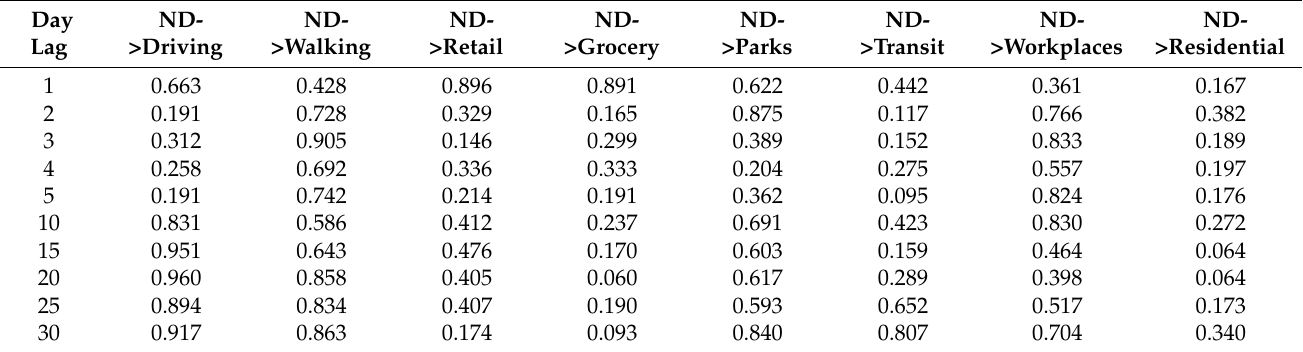
Table A18. New_deaths (ND), Granger-cause mobility variables, and p -values in day lags in Portugal.